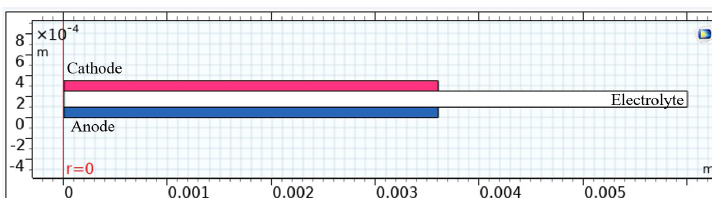
Figure 4. Planar cylindrical geometry in 2D axisymmetric space.